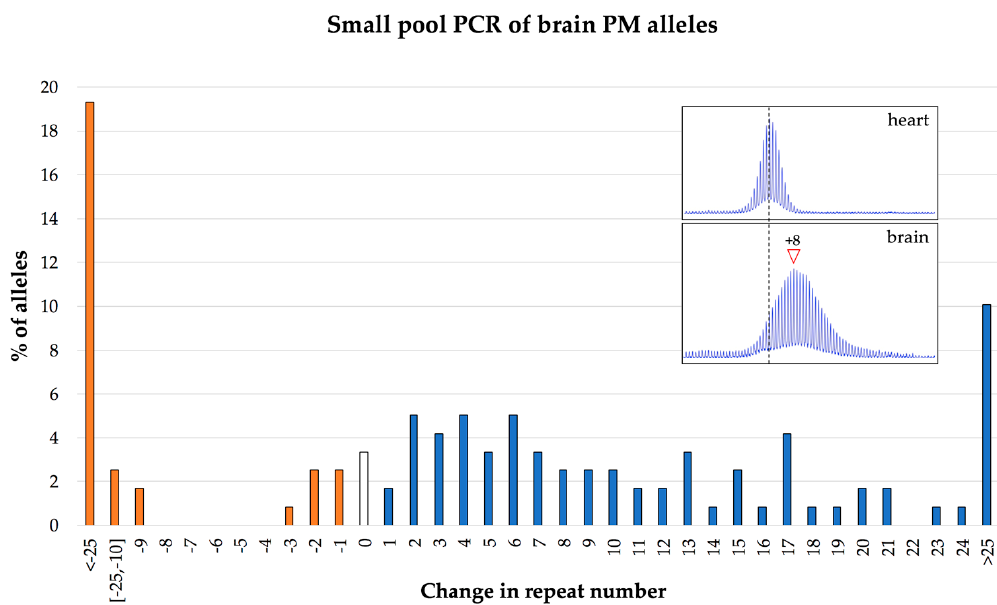
Figure 5. Distribution of the changes in the repeat number seen in the brain of a 1-year old mouse with an inherited allele of 162 repeats. The repeat number of individual alleles was determined by small pool PCR of single genome equivalents as described previously [30]. The data shown represent 119 individual PCR reactions. The inset panels show the bulk PCR profiles for the heart and brain of the same animal.